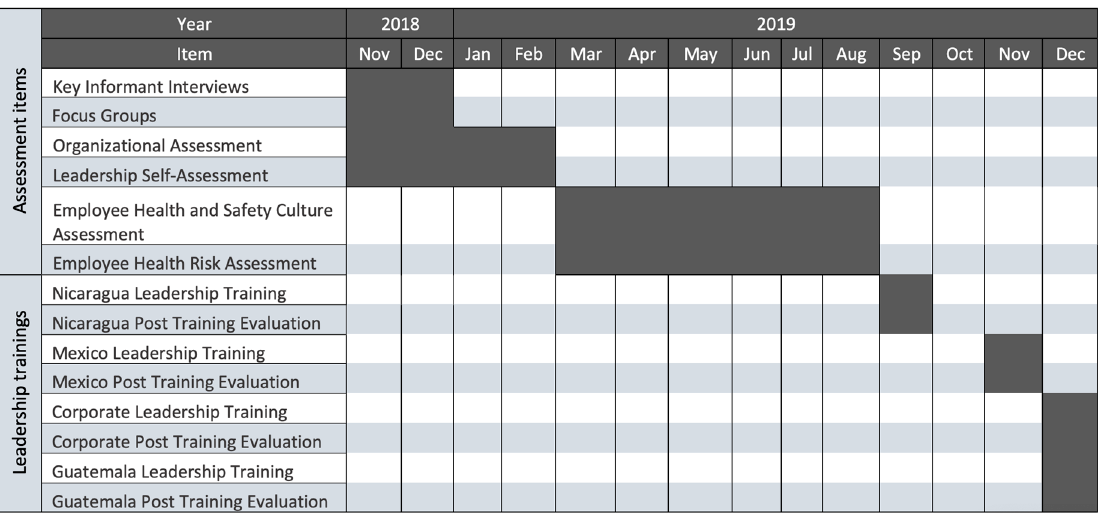
Figure 3. Timeline of TWH Needs Assessment and Leadership Trainings at